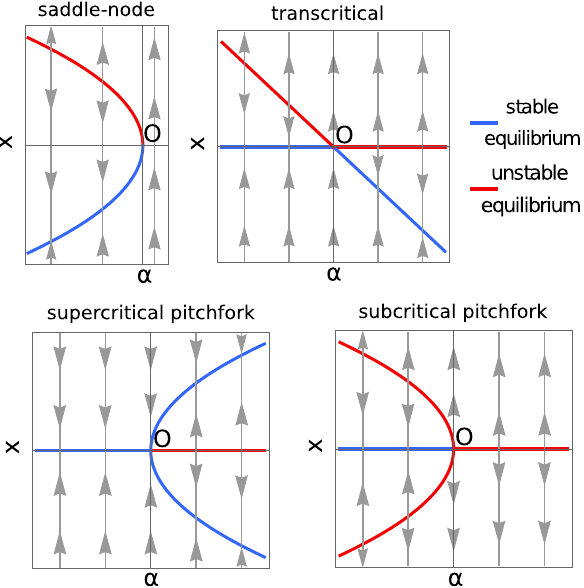
Fig. 16 Bifurcation diagrams corresponding to the normal forms (A.5)–(A.8). Bifurcations take place in the origin